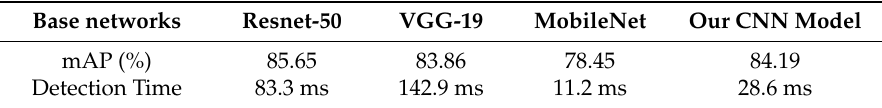
Table 9. Influence of different base networks on